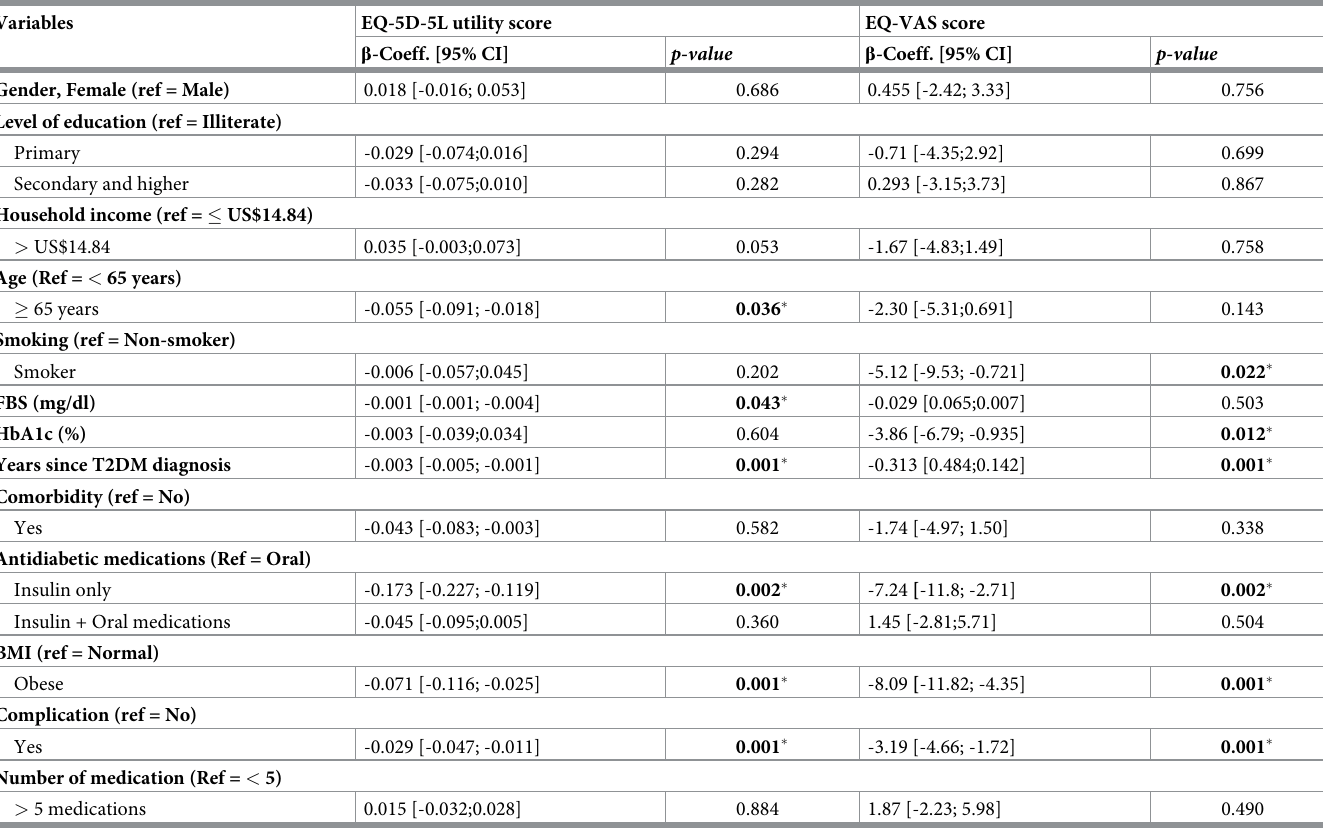
Table 4. Predictors of HRQoL in patients with Type-2 diabetes